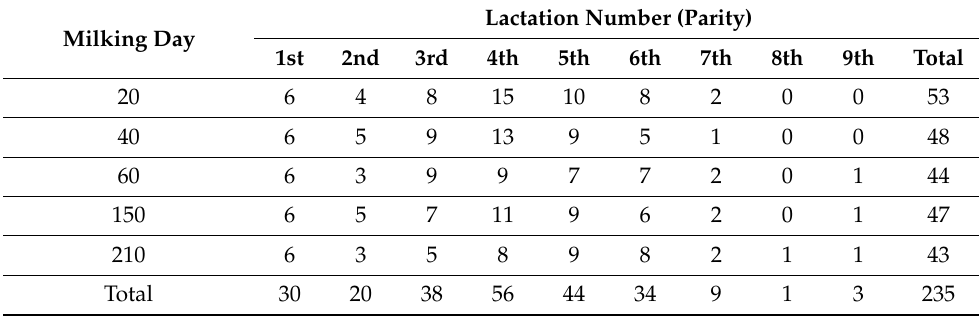
Table 1. Distribution of the milk samples according to parity and day of